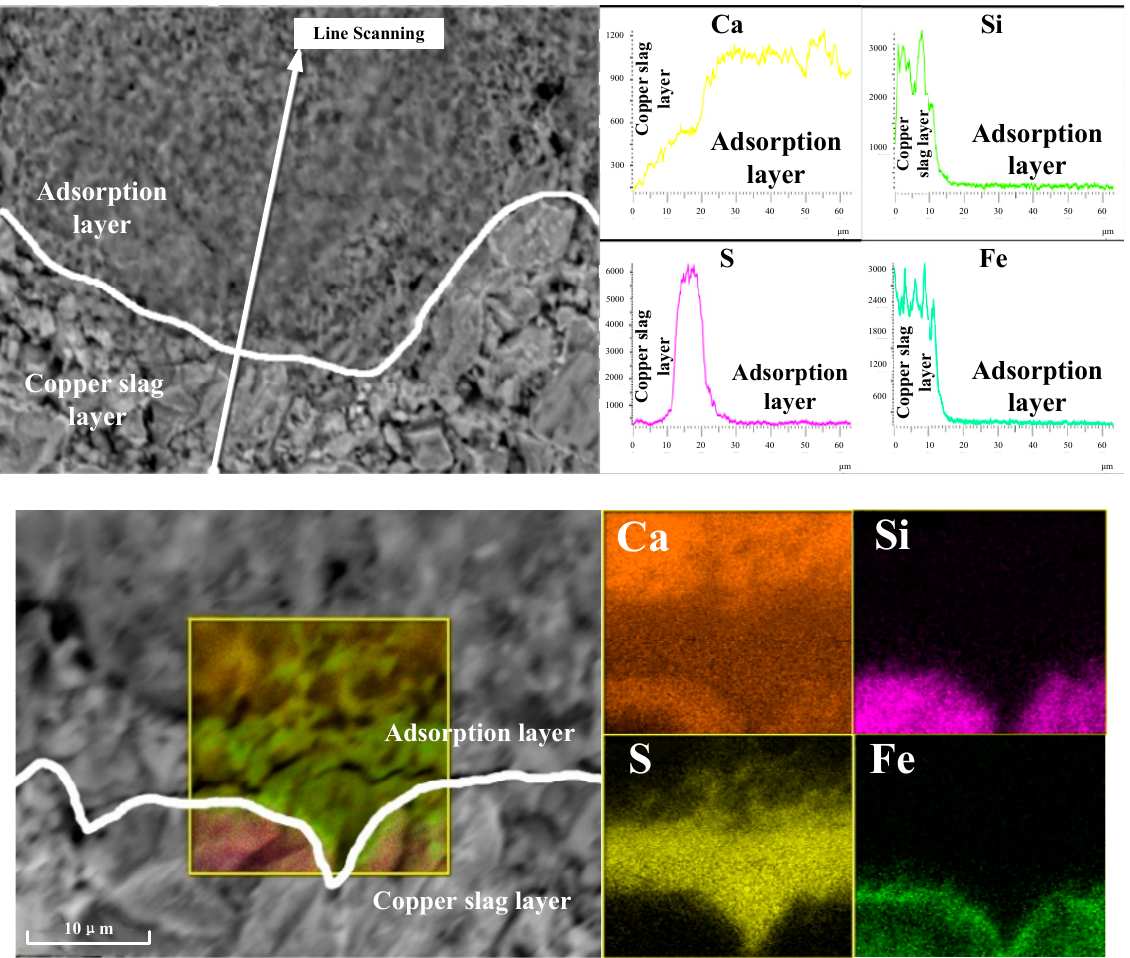
Figure 9. Elemental mapping distribution analysis of the interface between copper slag and calcium oxide.